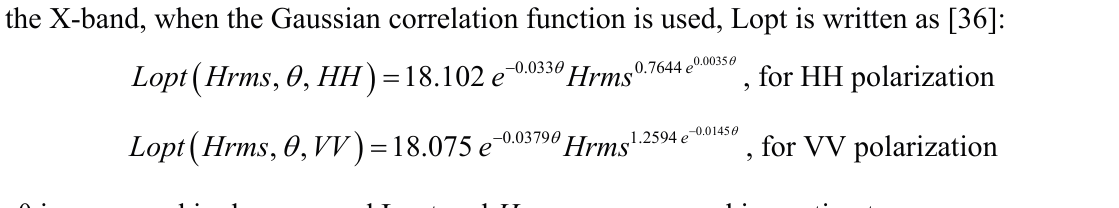
Figure 10. Comparison between X-band data and Dubois simulations: ( a ) HH polarization, at 36° incidence; ( b ) VV polarization, at 36° incidence; ( c ) HH polarization, at 26°